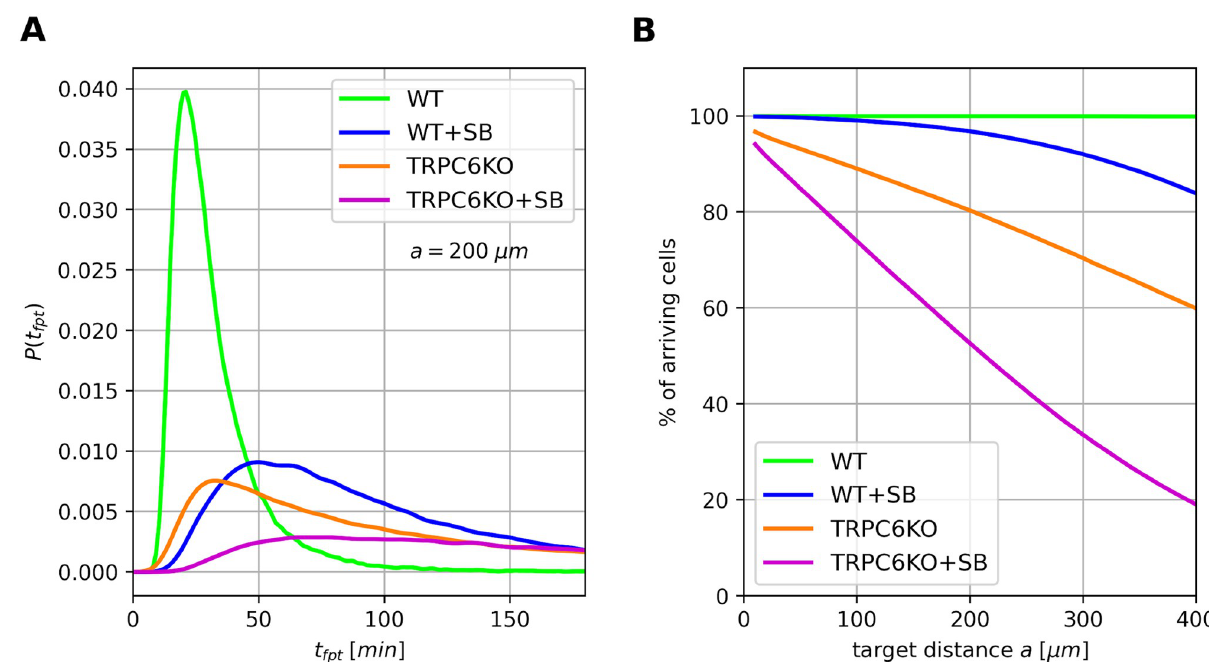
Fig 8. Comparison of arriving probabilities by simulations. (A) Probability distributions of first passage times for simulated cells at a distance of 200 μm . Model parameters calculated for the respective experimental conditions were used for simulations as given in Figs 5 and 6. There is a surge of WT neutrophils reaching their target after 20 min, whereas all other cell types show a delayed arrival. (B) Percentage of cells arriving at the target that is located at a distance a from the starting points of the cell ensemble. All simulated wildtype cells arrive at the target within 5 h, whereas CXCR2 inhibition and/or TRPC6 ablation markedly reduce the number of cells arriving at their target.